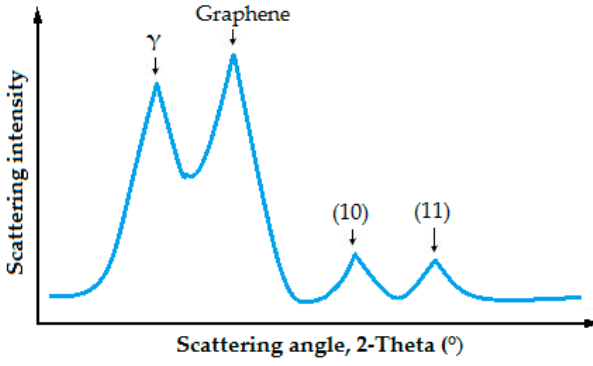
Figure 2. XRD pattern of a bitumen sample [40].